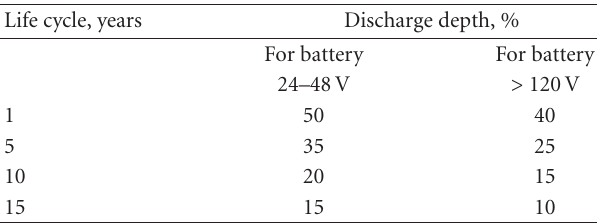
Table 2: Battery life cycle (years) versus discharge depth (%) for two di ff erent battery types.